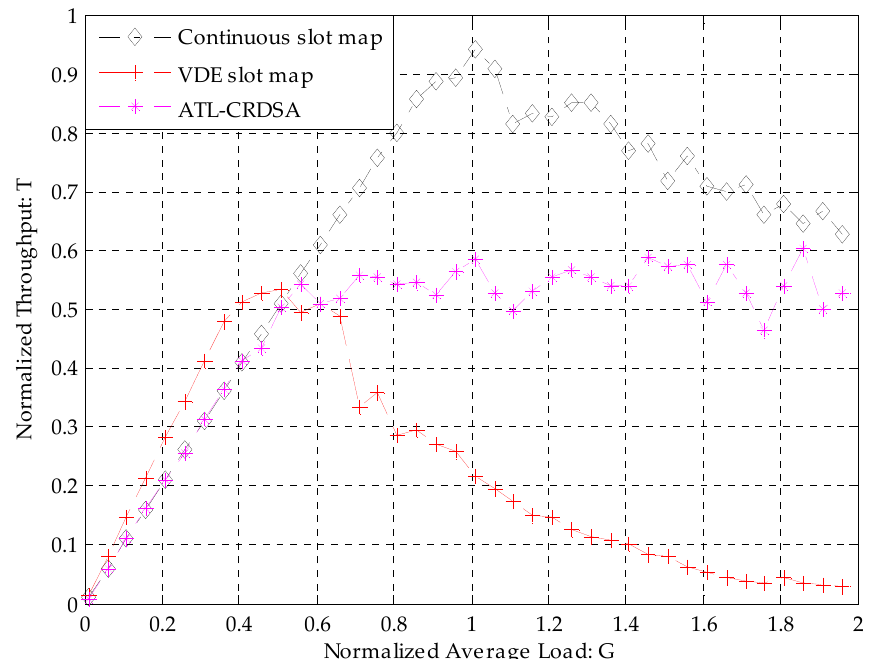
Figure 6. Normalized throughput of ATL-CRDSA in VDE slot map and CRDSA in continuous and VDE slot maps.